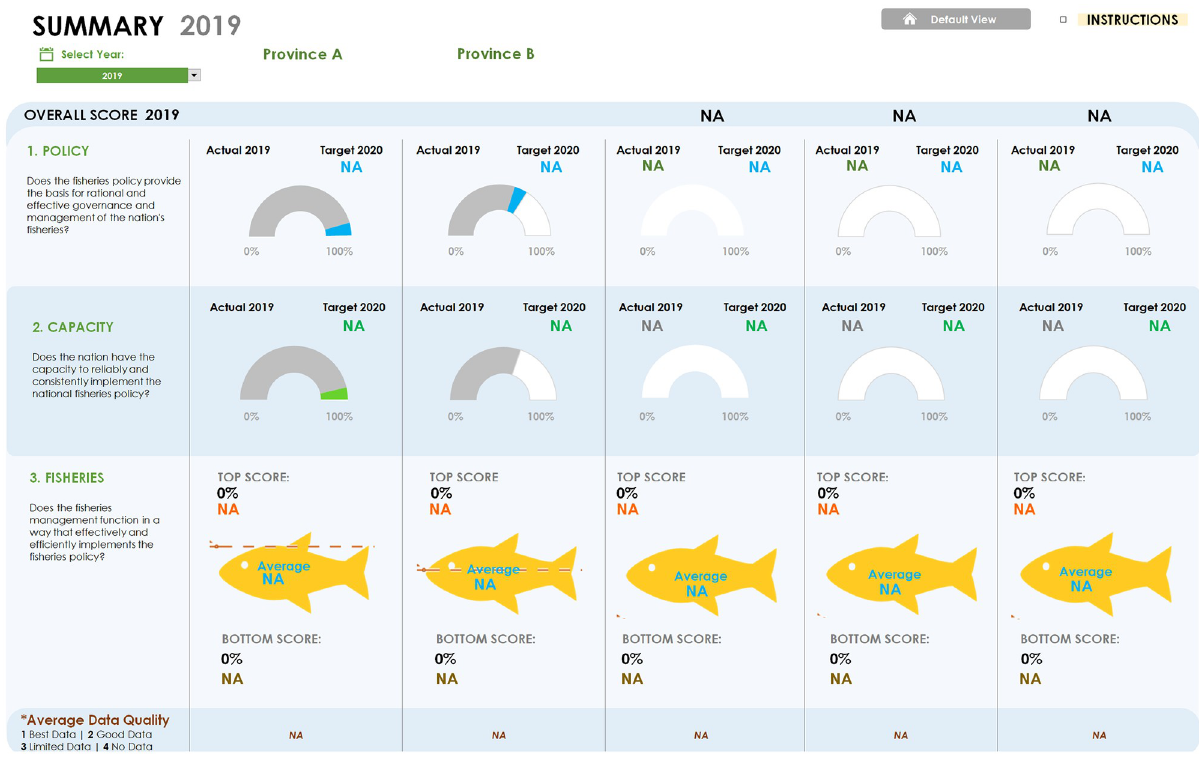
Fig 4. Outputs for Components 1 and 2 show a country’s progress based on measures achieved relative to optional targets set by the user. Component 3 shows progress of individual fisheries, also against optional targets. Fishery performance can be viewed in the context of the policy and capacity components to investigate where key strengths and weaknesses